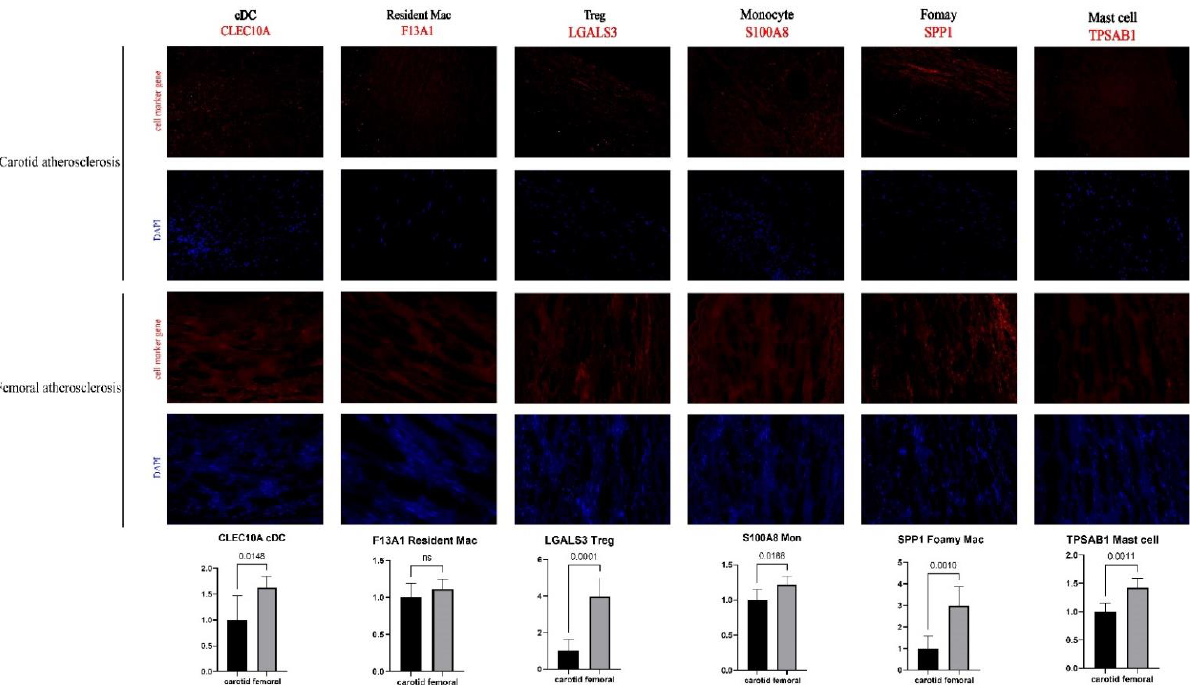
Figure 5. Validation of the difference in immune-cell count through immunofluorescence staining. cDCs were labeled by CLEC10A. Resident macrophages were labeled by F13A1. Regulatory T cells were labeled by LGALS3. Monocytes were labeled by S100A8. Foamy macrophages were labeled by SPP1. Mast cells were labeled by TPSAB1.